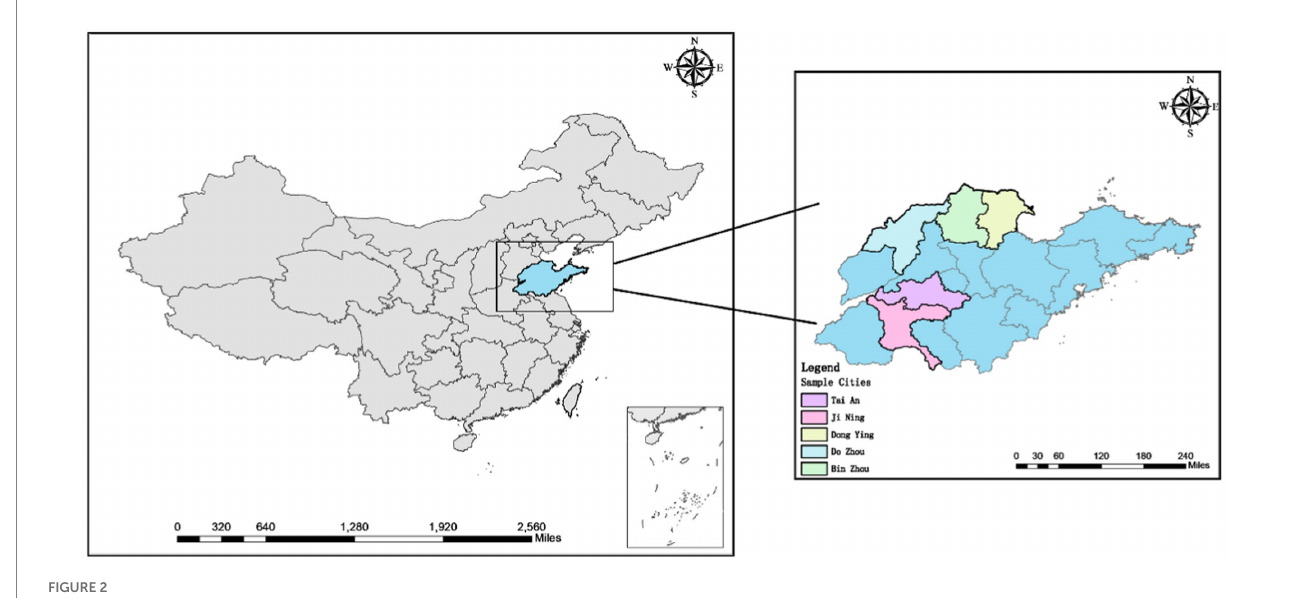
FIGURE 2 Survey